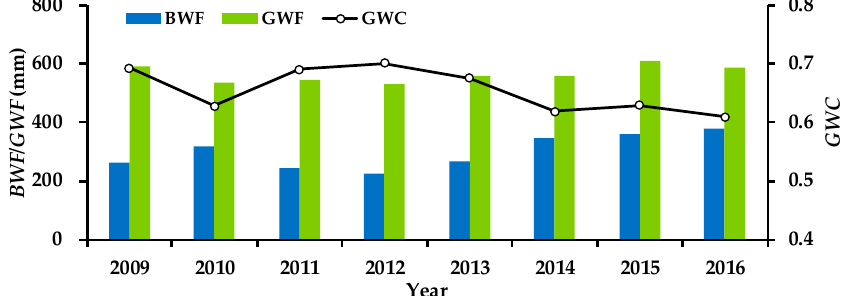
Figure 8. Changes in water flows and green water coefficient from 2009 to 2016: The blue bar represents blue water flow (BWF), and the green bar represents green water flow (GWF). The line with circles represents the green water coefficient (GWC).